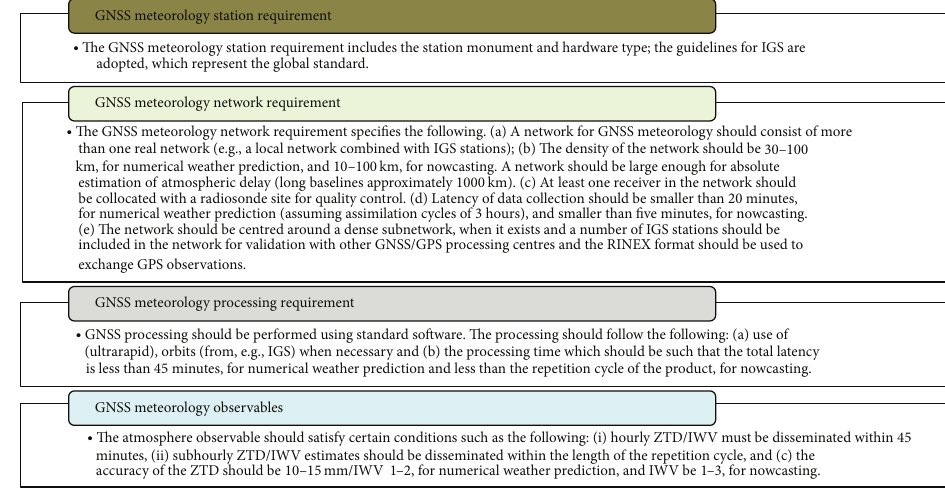
Figure 1: Summary of requirements for GNSS meteorology from IGS, GRUAN, and EUREF.